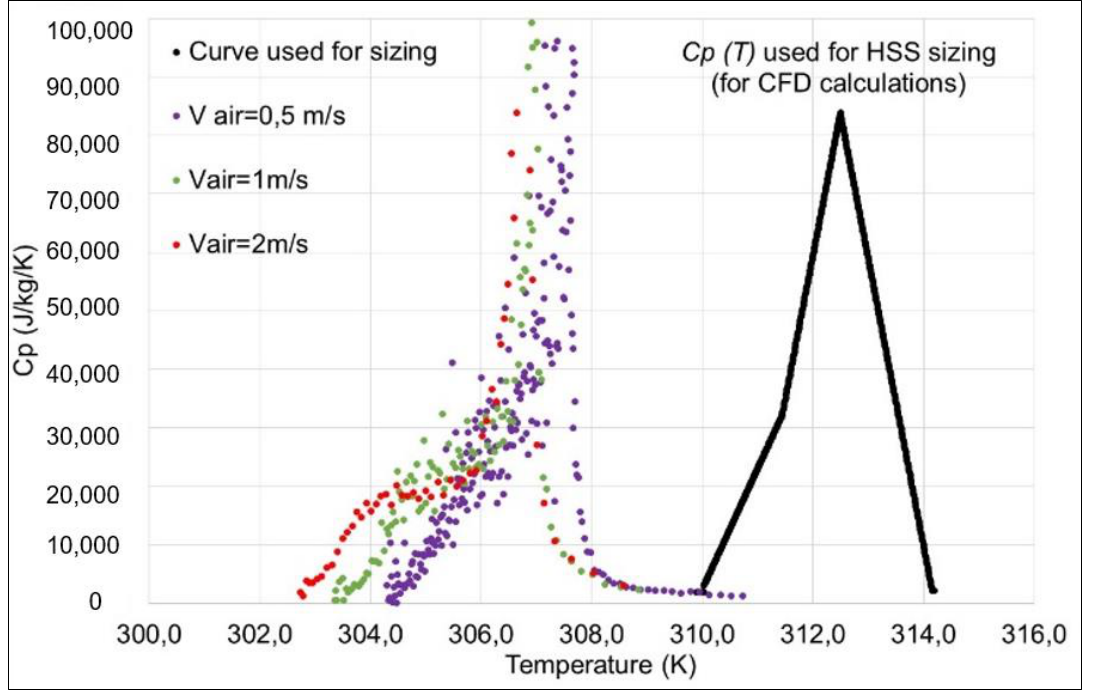
Figure 21. Comparison between the specific heat capacity of the composite evaluated from the experimental data during PCM solidification and that assumed in the CFD model.